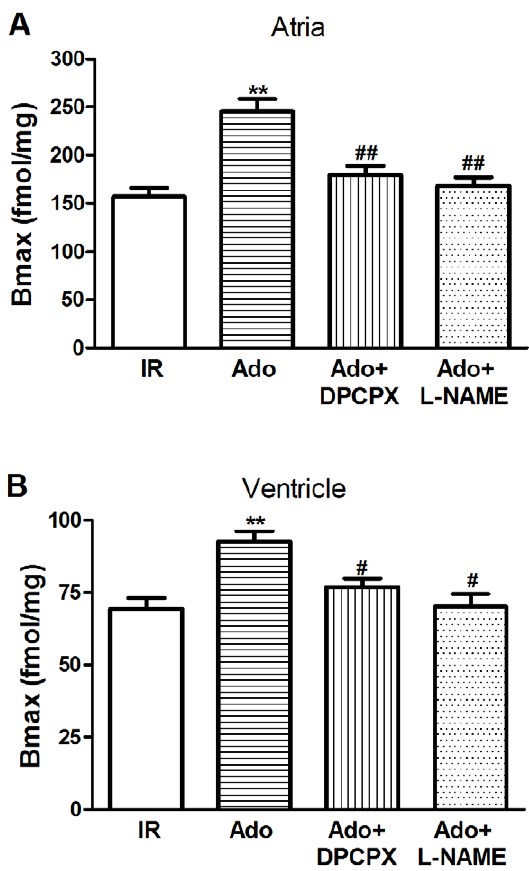
Figure 7. Effects of adenosine on the B max of MAChR. Adenosine increased the B max of MAChR both in atria (A) and in ventricle (B) of ischemic-reperfused myocardium. DPCPX or L-NAME abolished this effect. IR: ischemic reperfusion; Ado: adenosine; P , 0.05, ** P , 0.01 vs. IR; # P , 0.05, ## P , 0.01 vs. Ado (n=6 in each group).